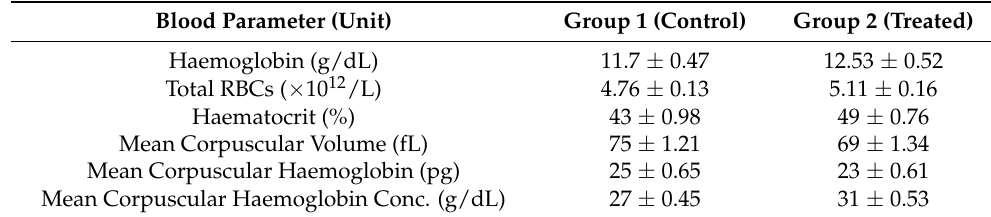
Table 5. Haematological findings of rabbit’s blood after Ins-Mmt-hydrogel NC administration (mean ± S.D, n = 6, analysis date 27 May